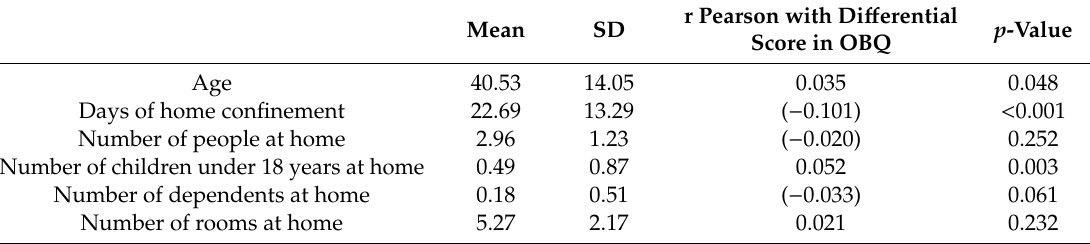
Table 2. Correlation between di ff erential OBQ scores and sociodemographic